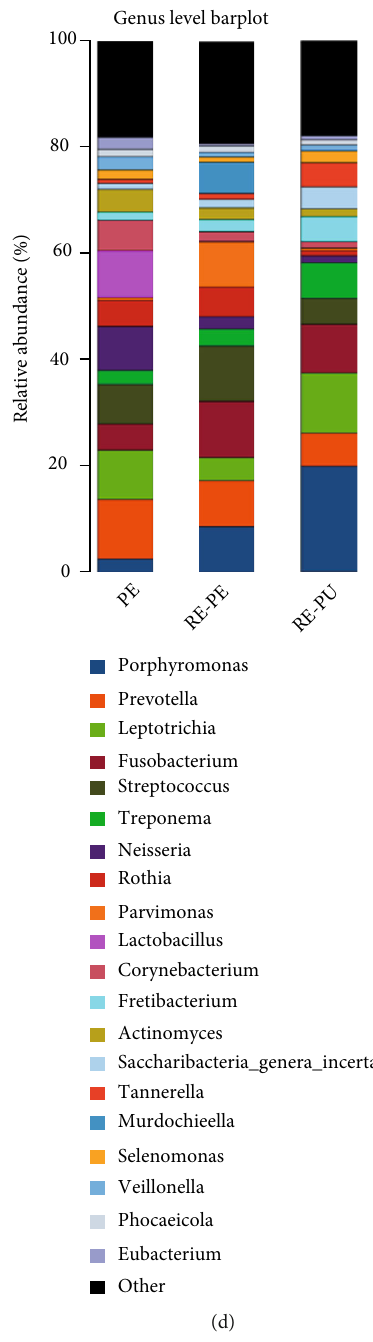
Figure 3: The analysis of microbial community structure of PU, RE-PU, and RE-PE groups. (a, b) The boxplot diagrams showed alpha diversity index among PU, RE-PU, and RE-PE. (c) The plot of principal coordinates analysis (PCoA) showed intergroup distances by 2 principal coordinates. (d) The relative abundance of top 20 bacterial taxa at the genus level for PU, RE-PE, and